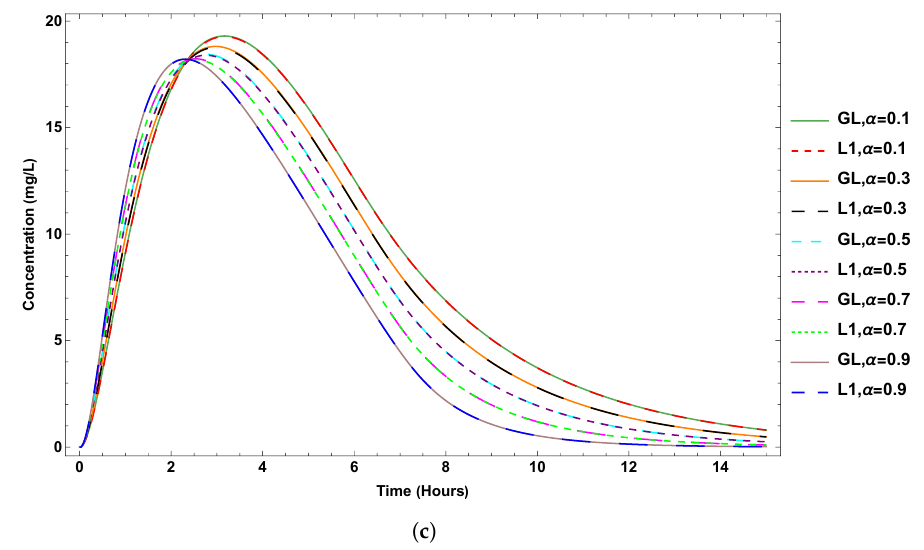
Figure 3. The oral administration route model, as a function of time, is fixed, along with several α values. ( a ) The gastrointestinal tract. ( b ) The central compartment. ( c ) The peripheral compartment.